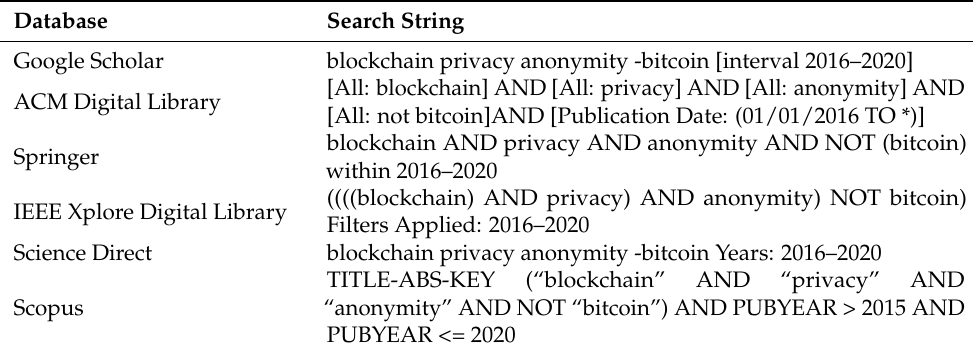
Table 1. Search strings in scientific